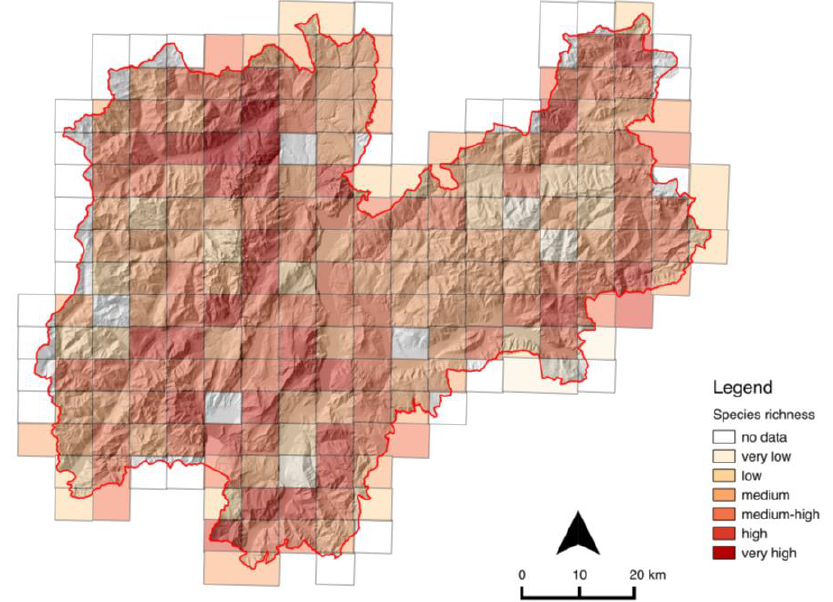
Figure 6. Species richness map overlaid with a hill-shaded layer.